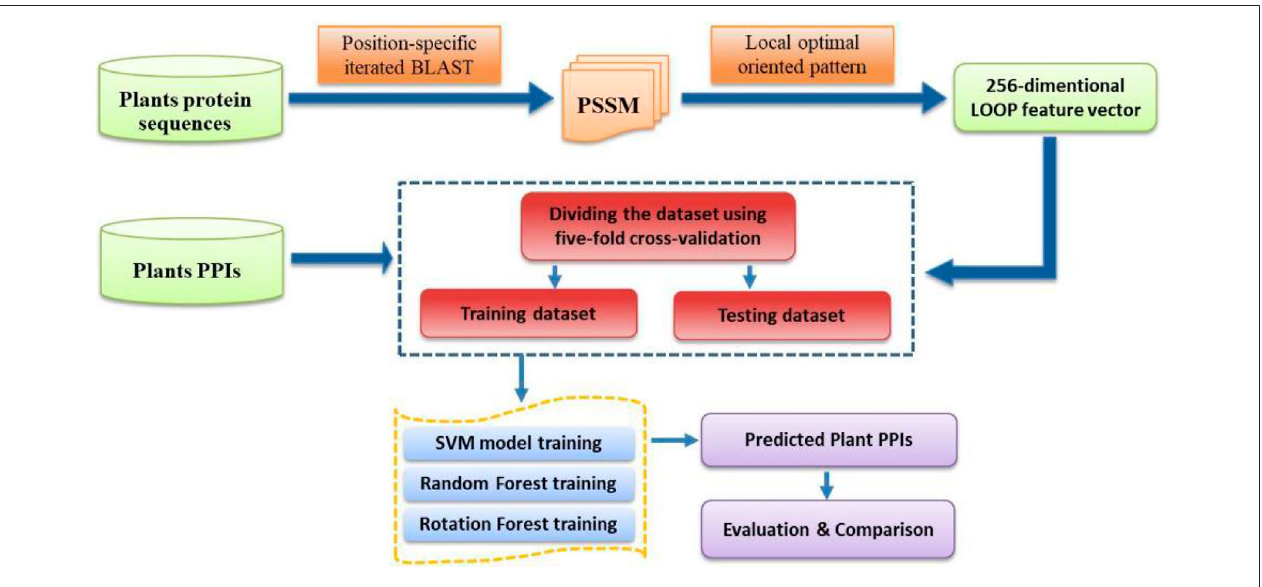
FIGURE 1 | The fl owchart of the proposed CPIELA method.